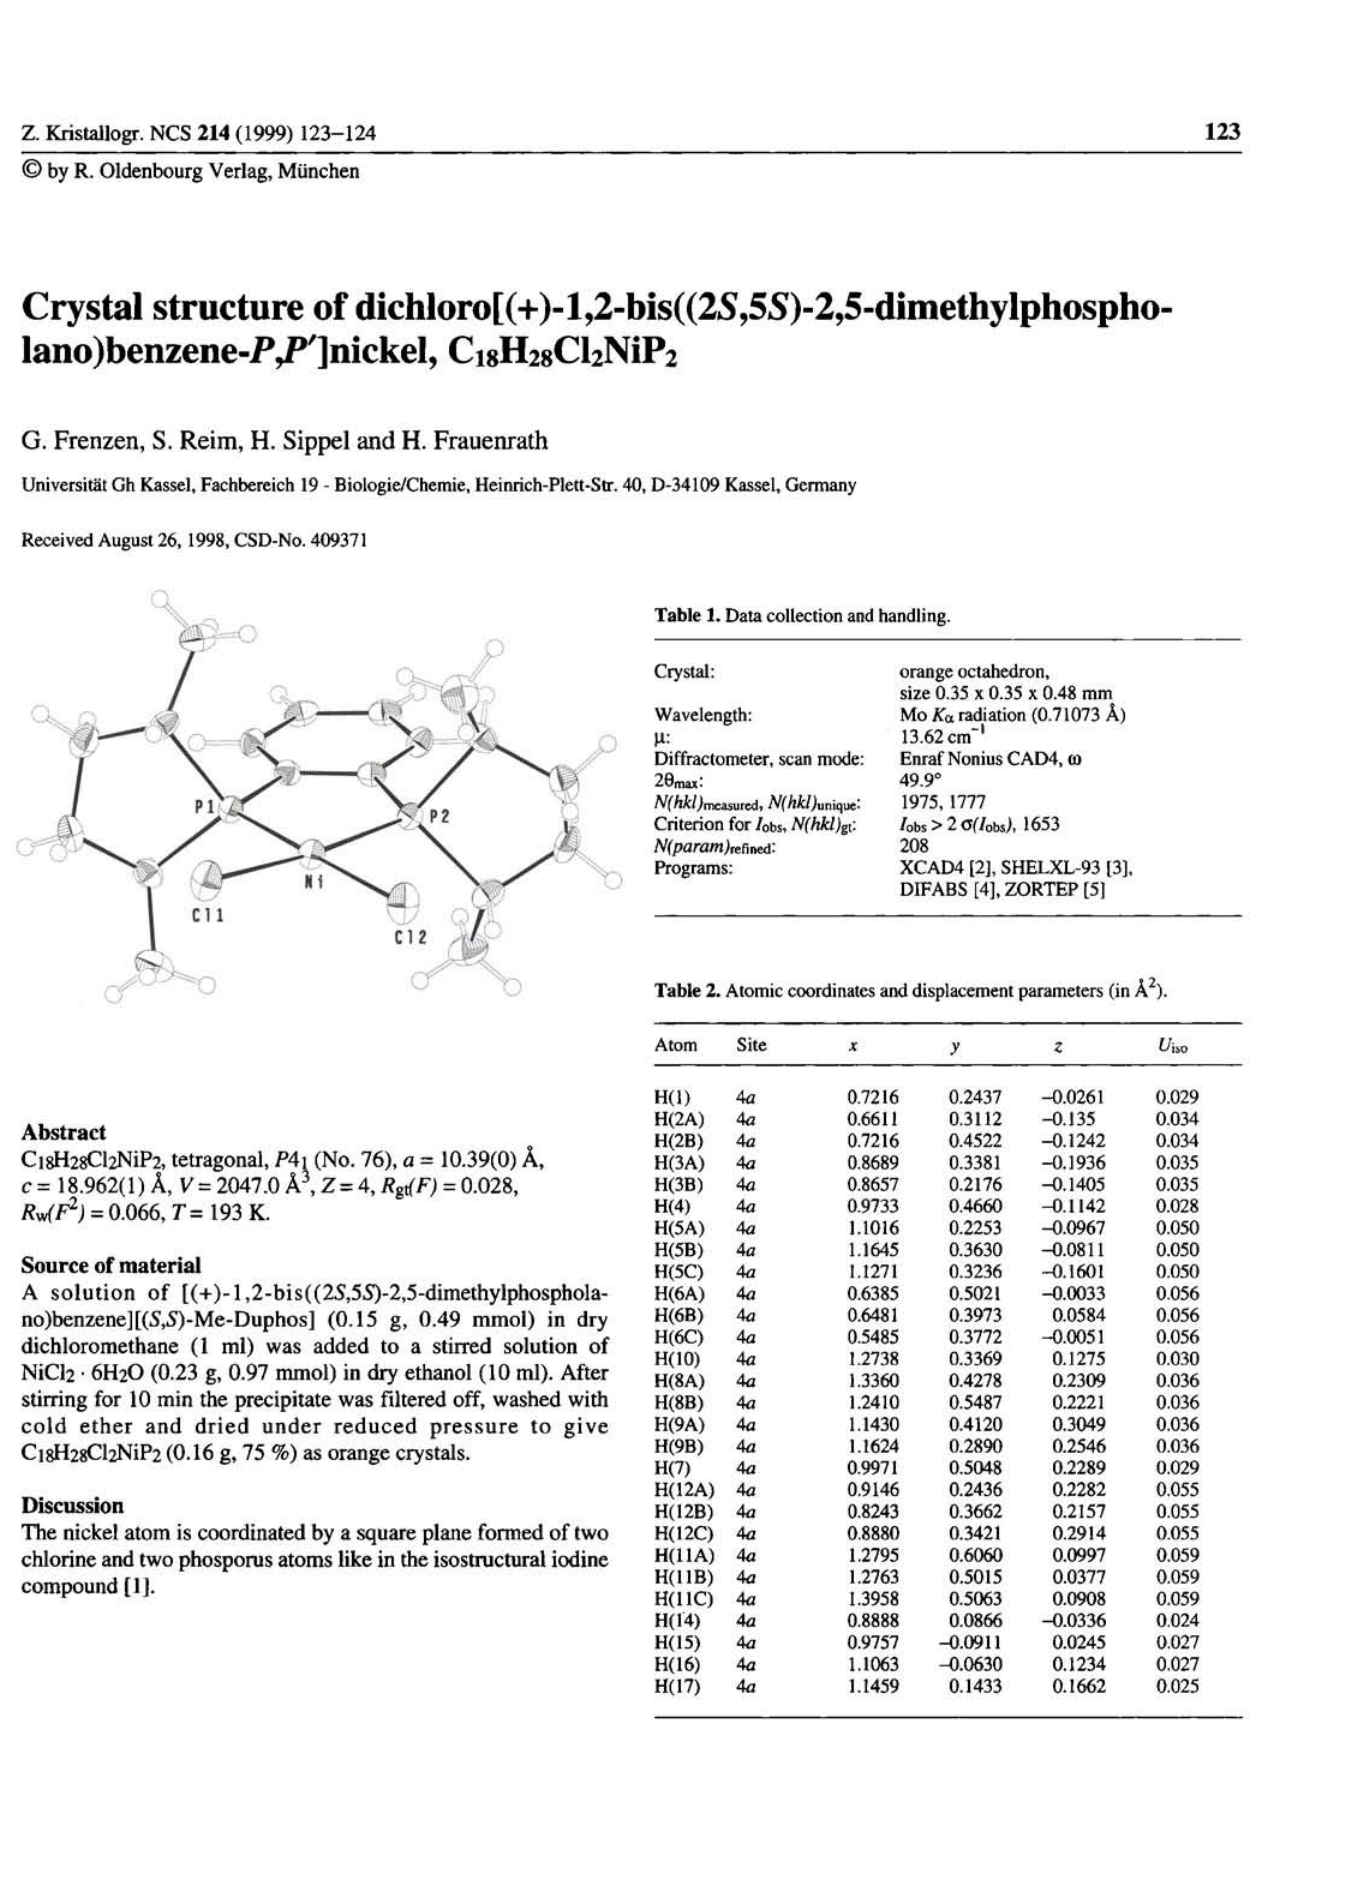
Table 2. Atomic coordinates and displacement parameters (in Â 2